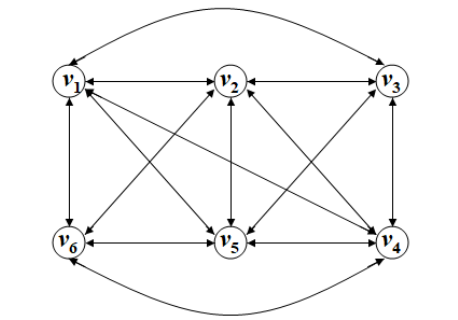
Figure 4. A graph G with n = 6 nodes, which is ( 3,3 ) -robust.